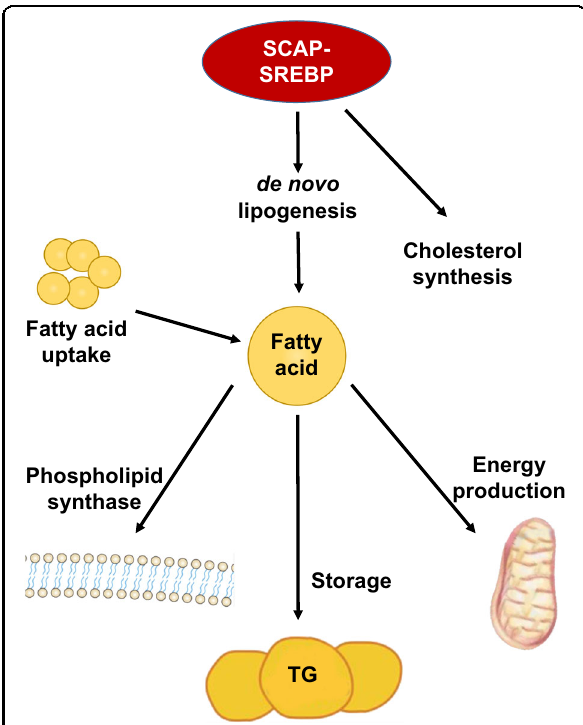
Fig. 2 The function of SREBP-SCAP in lipid metabolism. Activation of SCAP – SREBP as the master regulator of lipid metabolism stimulates the transcription of enzymes required for de novo lipogenesis and receptors that mediate the uptake of fatty acids released by